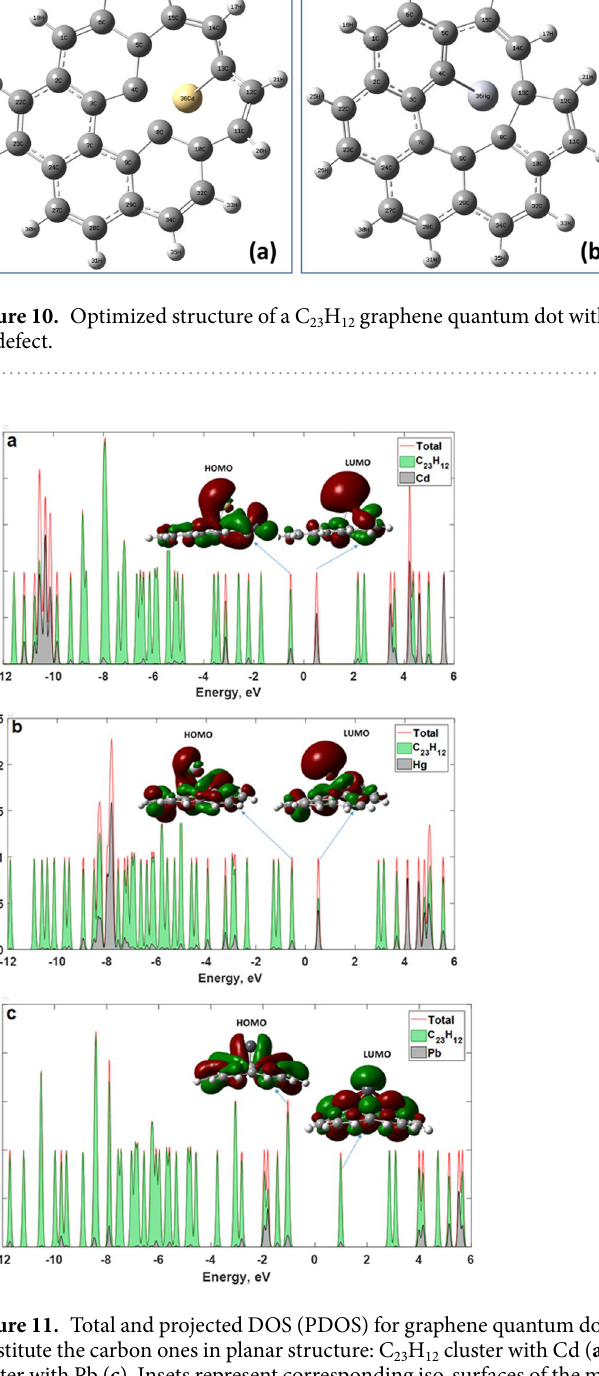
from the Cd atom, whereas the orbitals of the C 23 H 12 dominate the HOMO (Fig. 11a). For the Hg-C 23 H 12 GQD, one can observe that the contribution of the Hg atom to the formation of the bottom of the conduction band is slightly less than the contribution of orbitals from C 23 H 12 (Fig. 11b). In the case of Pb-doped cluster, the orbital